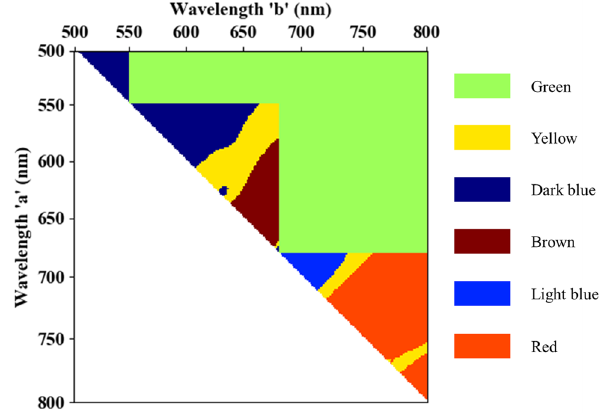
Figure 7. The range of wavelength ‘a’ and ‘b’ under some restrictions.